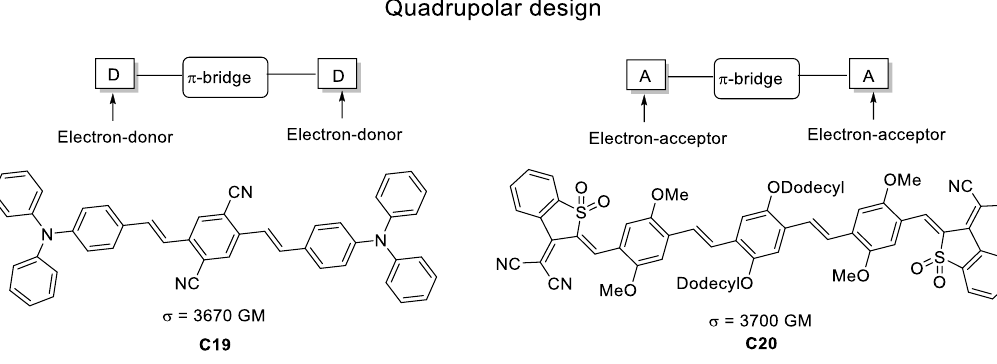
Figure 25. Most promising D-π-A- π -D and A-π-D- π -A molecular topologies in one-dimensional TPA chromophores.